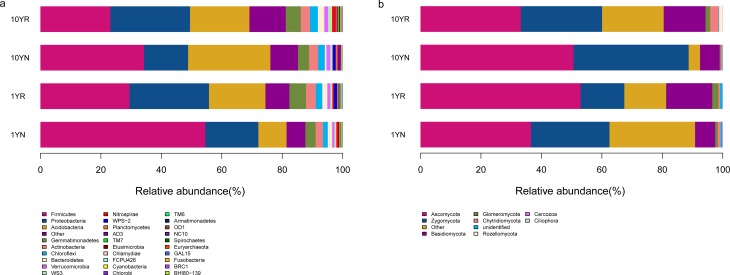
Relative abundances of the dominant bacterial (a) and fungal (b) taxa in 1-year and 10-year continuous-cropping ramie soil samples at the phylum level. which were identified using the RDP classifier. Sequences not classified into any known group were designated as “Other”.